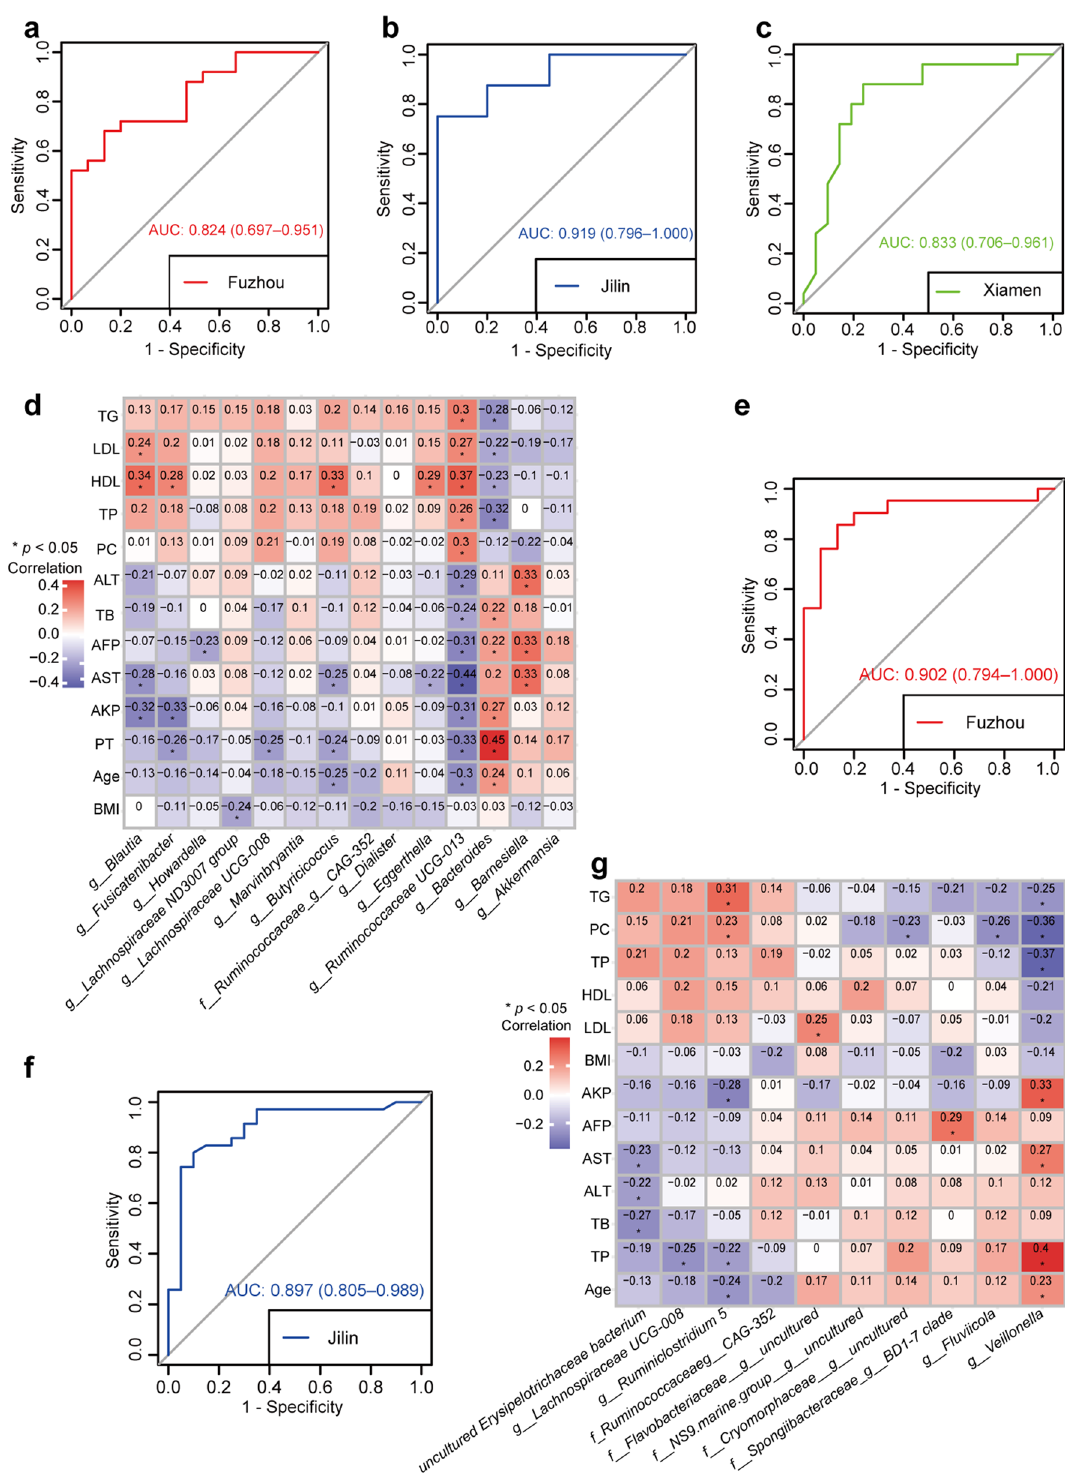
Fig. 4 The performances of two RF models based on 14 LC-associated genera or 10 HCC-associated genera. a – c ROC curve of the RF model based on 14 LC-associated genera in Fuzhou, Jilin and Xiamen samples. d The heatmap of the relationships between 14 LC-associate genera and 13 clinical indicators. e – f ROC curve of the RF model based on 10 HCC-associated genera in Fuzhou and Jilin samples. g The heatmap of the relationships between 10 HCC-associated microbial genera and 13 clinical